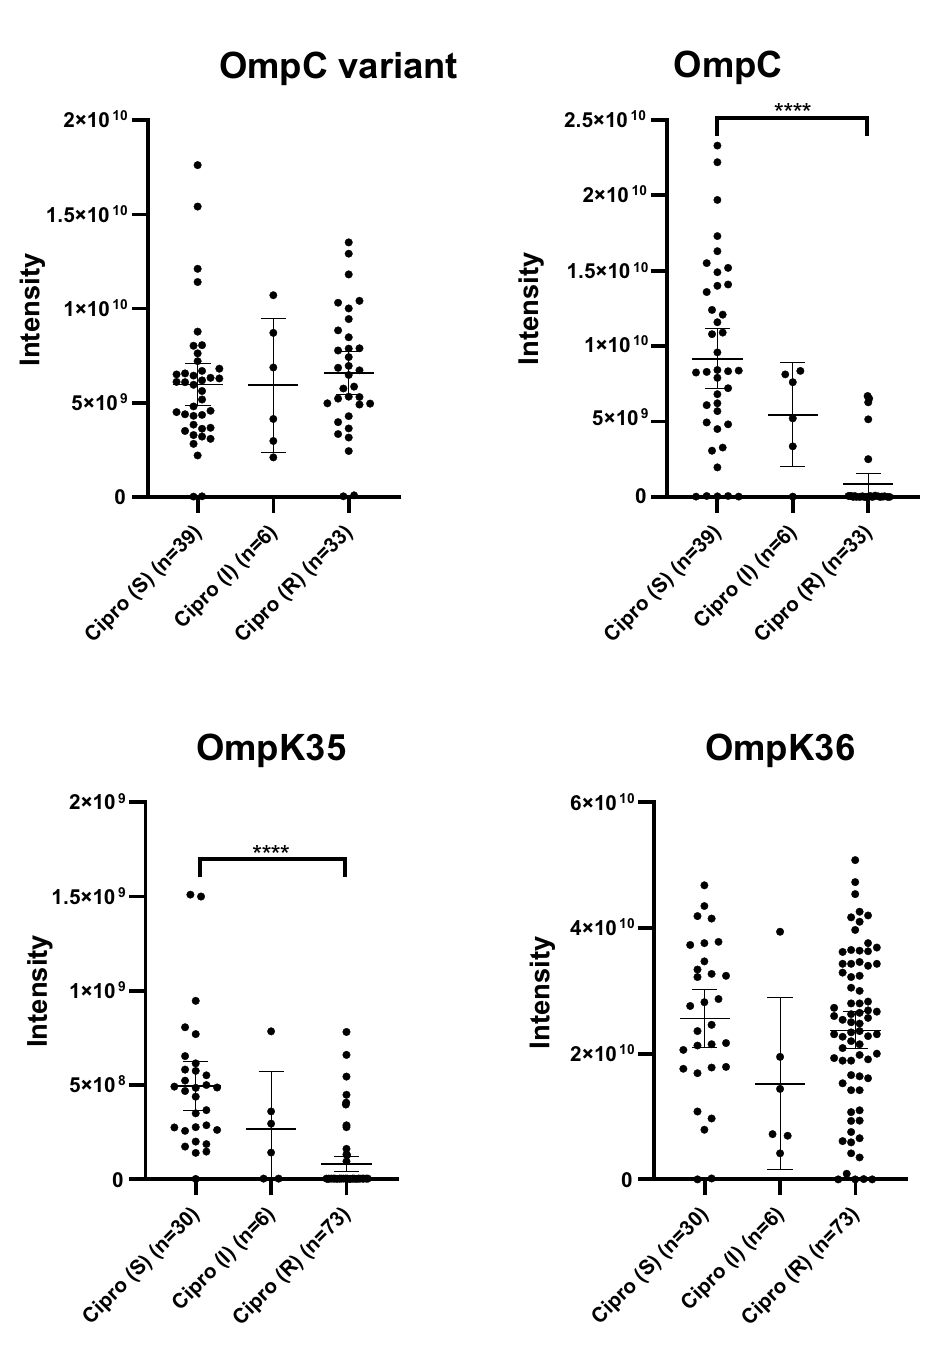
Figure 4. Porin abundance was compared between ciprofloxacin susceptible, intermediate and resistant E. coli and K. pneumoniae isolates. Signal intensities for the different porins are shown in arbitrary units for the “regular” OmpC and the OmpC variant in E. coli , and for OmpK35 and OmpK36 in K. pneumoniae . ****p-value < 0.0001 (Ordinary one-way Anova, Turkey’s multiple comparisons